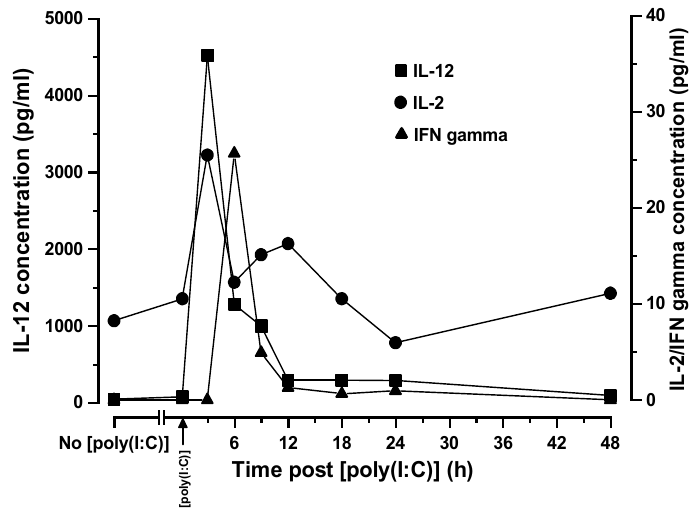
Figure 2. Serum concentrations of IL-2, IL-12, and INF γ at various time points out to 48 h after i.v. injection of 100 µ g of [poly (I:C)] into SCID mice.